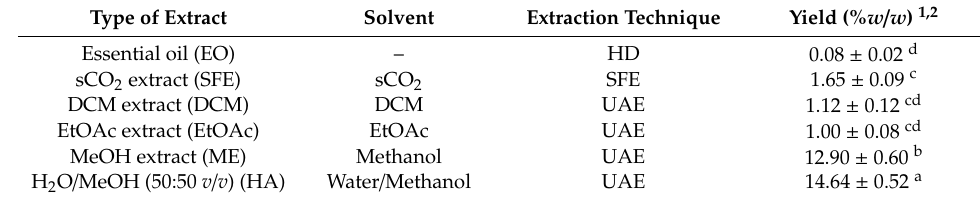
Table 1. S. sipylea extracts of different polarity and their % ( w / w ) yields.